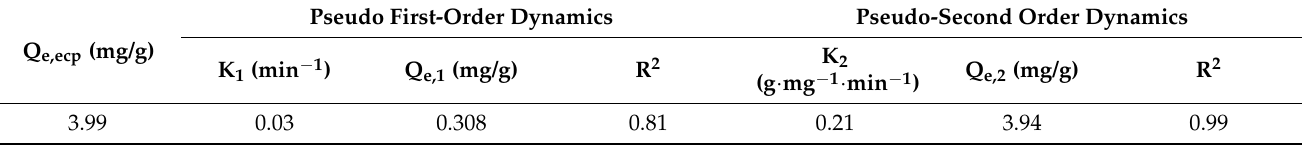
Figure 8. ( a ) Pseudo–primary (PFO) kinetic model, and ( b ) pseudo–secondary (PSO) kinetic model. Table 2. Kinetic model parameters.